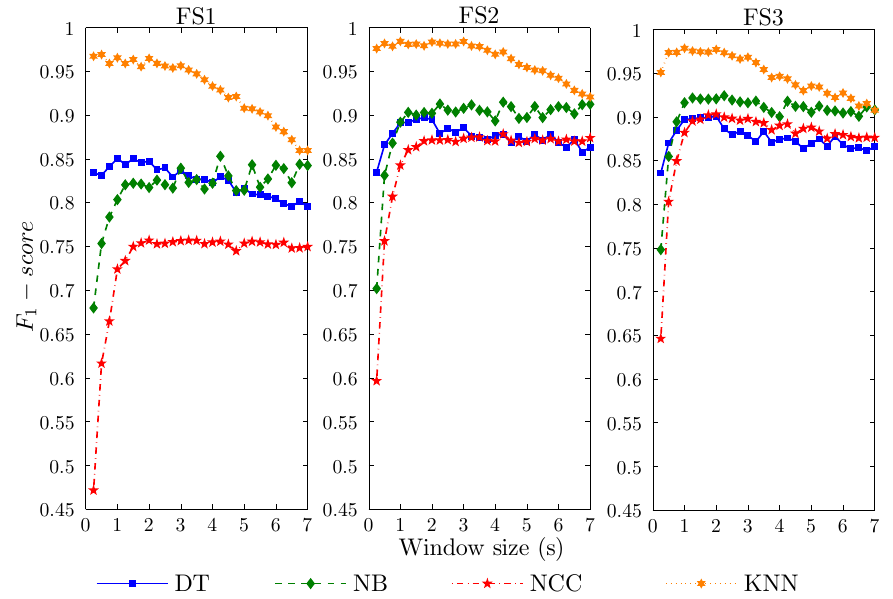
Figure 3. Effect of the data window size on the activity recognition system performance ( F - score ). Twelve recognition systems, respectively, corresponding to the combination of 1 three feature sets (FS1, FS2, FS3) and four classification models (DT, NB, NCC, KNN) are